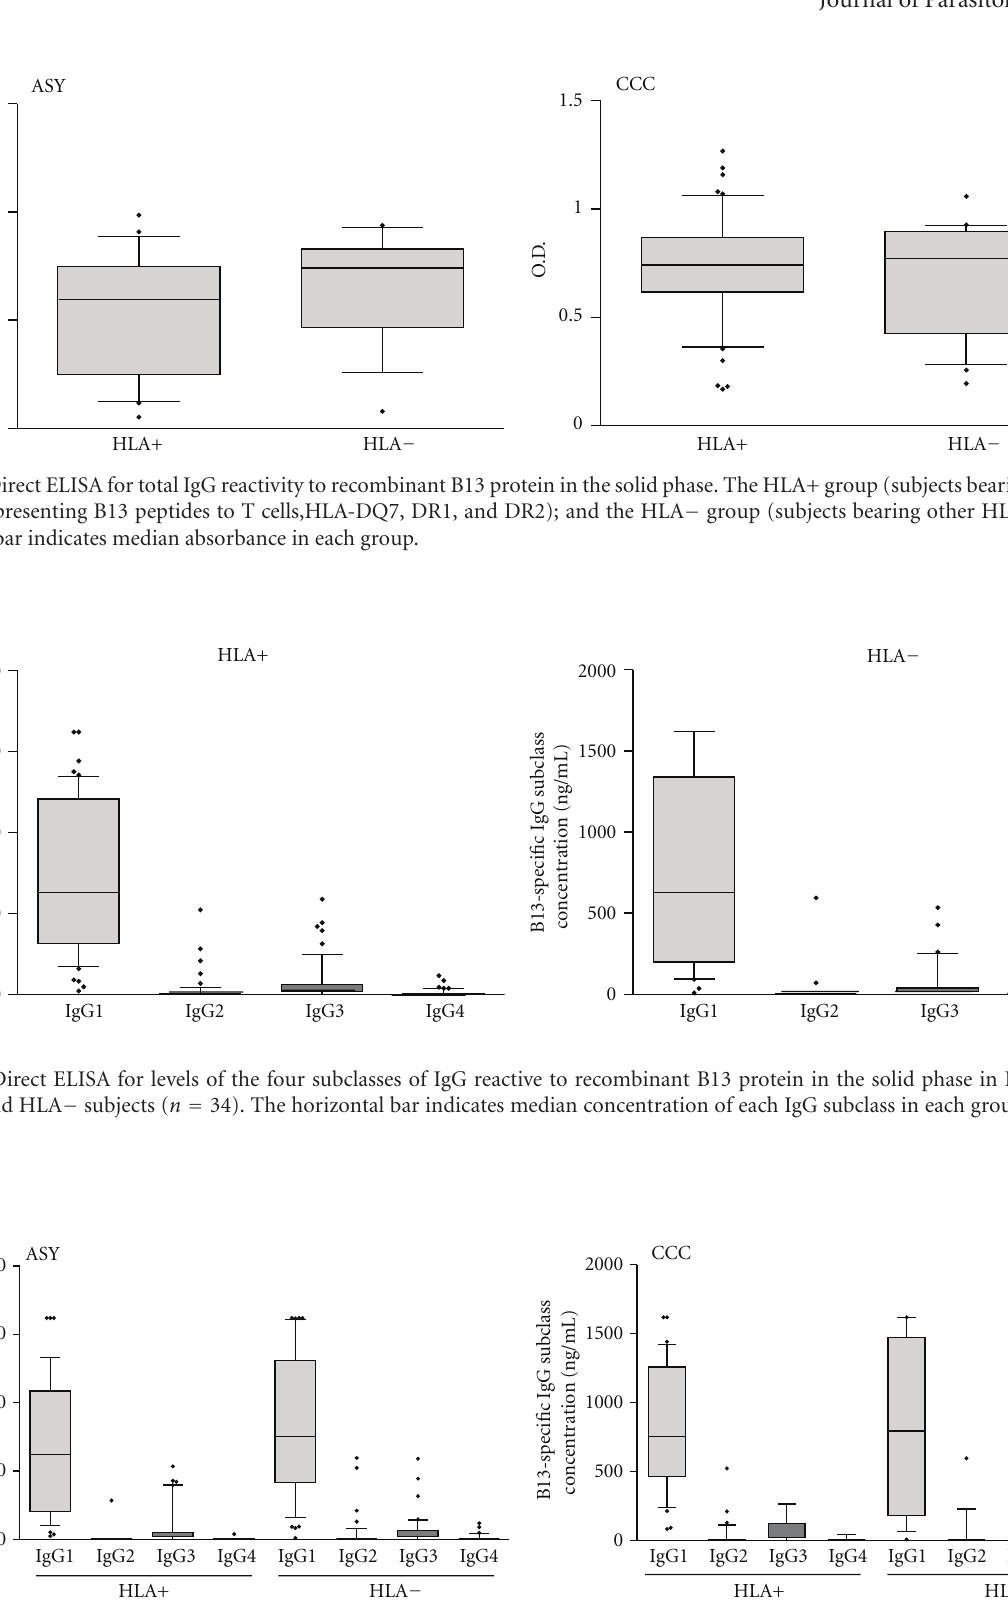
Figure 5: Direct ELISA for levels of the four subclasses of IgG reactive to recombinant B13 protein in the solid phase in ASY and CCC subjects; HLA+: subjects bearing HLA alleles capable of presenting B13 peptides to T cells (HLA-DQ7, DR1, and DR2); HLA − : subjects bearing other HLA alleles. The horizontal bar indicates median concentration of each subclass in each group: IgG1; 2: IgG2; 3: IgG3; 4: